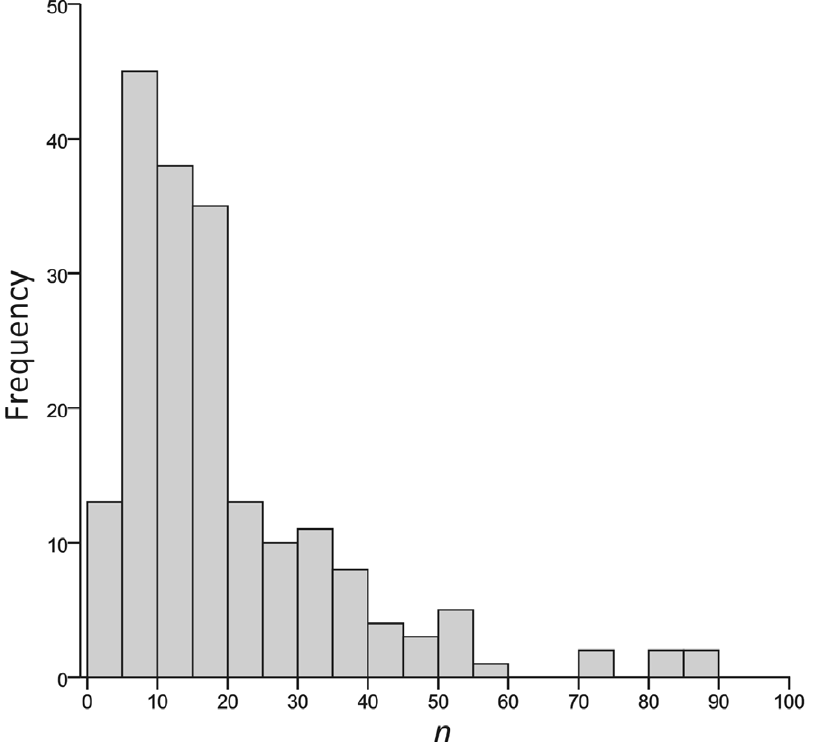
Figure 1. Frequency distribution of sample sizes for estimating population niche widths in published studies using stable isotope methods (TA or SEA). The data were sourced through literature search in ISI Web of Knowledge and Scopus and publications are listed in Appendix S1.